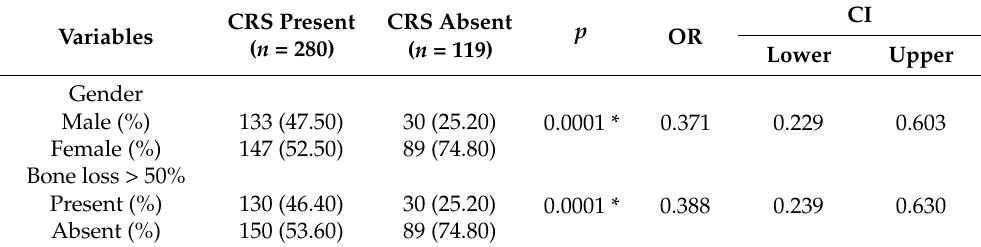
Table 3. Association of CRS and clinical variables using a stepwise variables selection